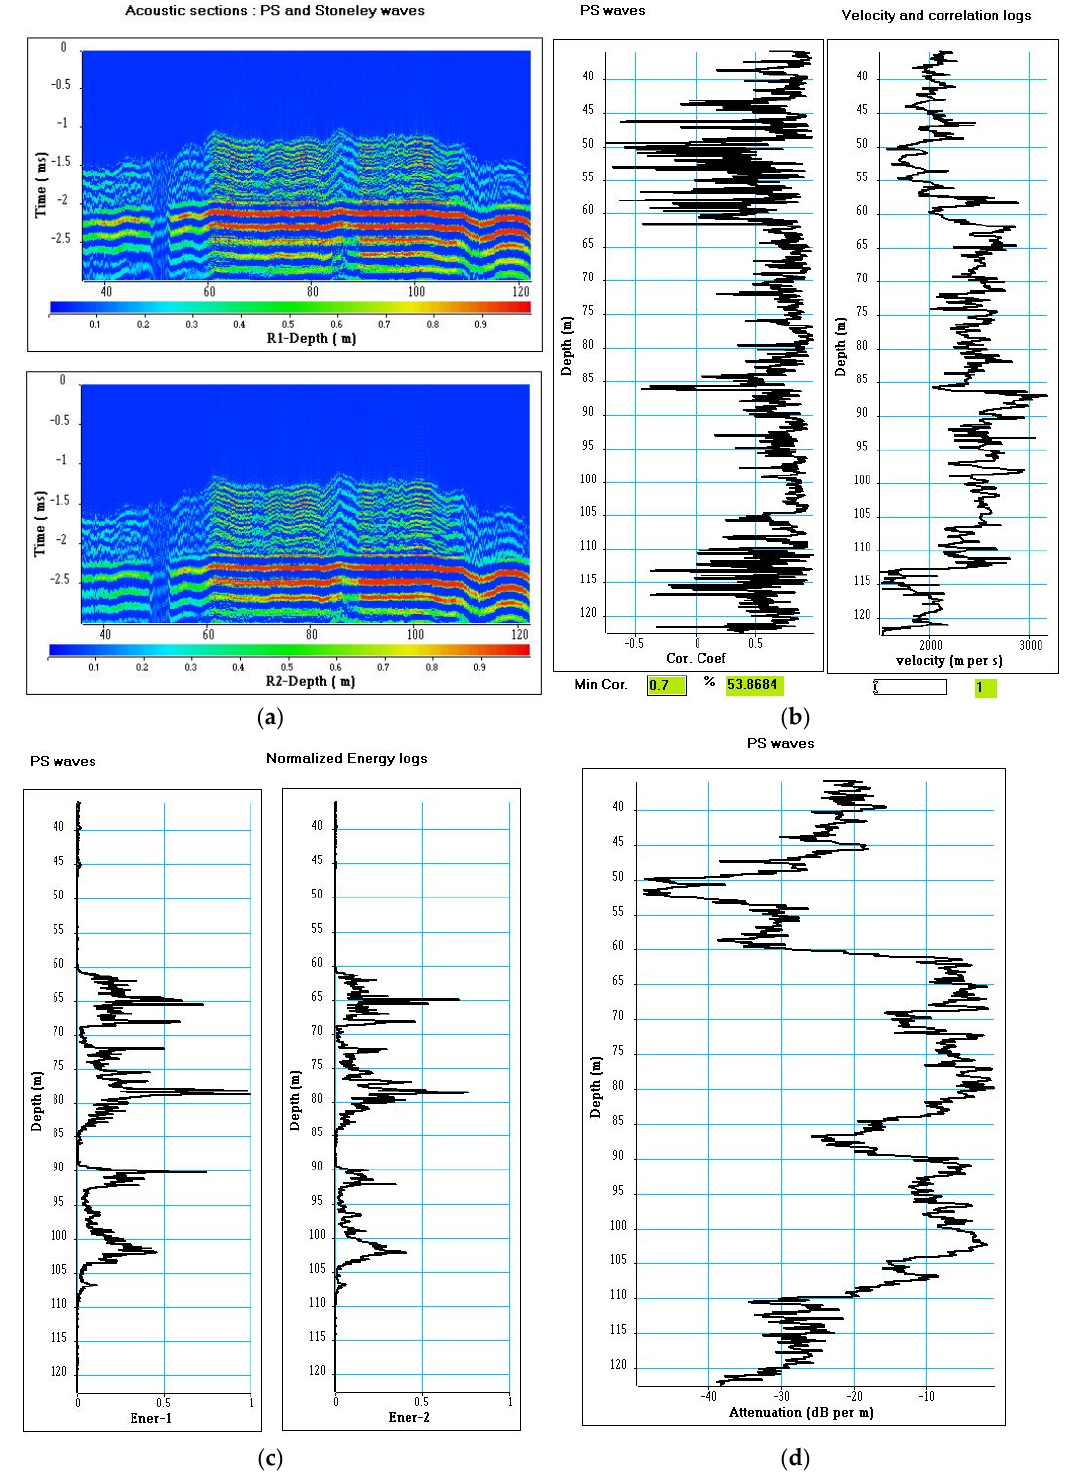
Figure 10. Converted refracted S ‐ waves. ( a ) Acoustic sections after mute. Vertical axis: recording time in ms, horizontal axis: depth of receiver R1 or R2, color scale: normalized amplitude, ( b ) velocity log and its associated correlation coefficient log, ( c ) normalized energy logs, ( d ) attenuation log. For the converted refracted S ‐ wave, the correlation coefficient is high in the 60–105 m depth interval, whereas the poor signal to noise ratio in the 35–60 m and 105–124 m depth intervals renders